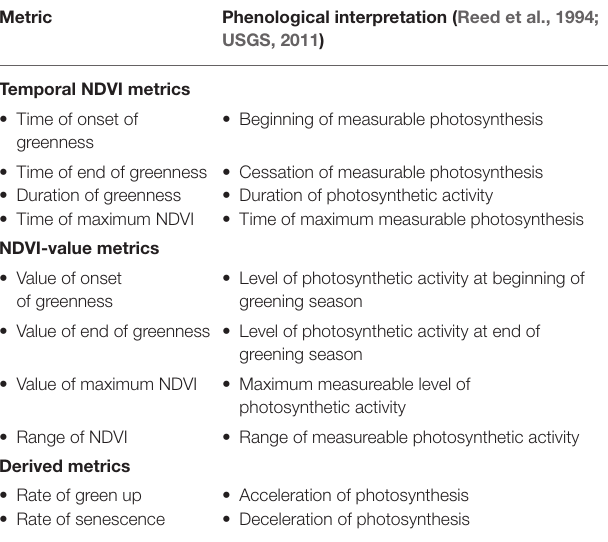
TABLE 1 | Seasonal NDVI metrics and their phenological interpretation.